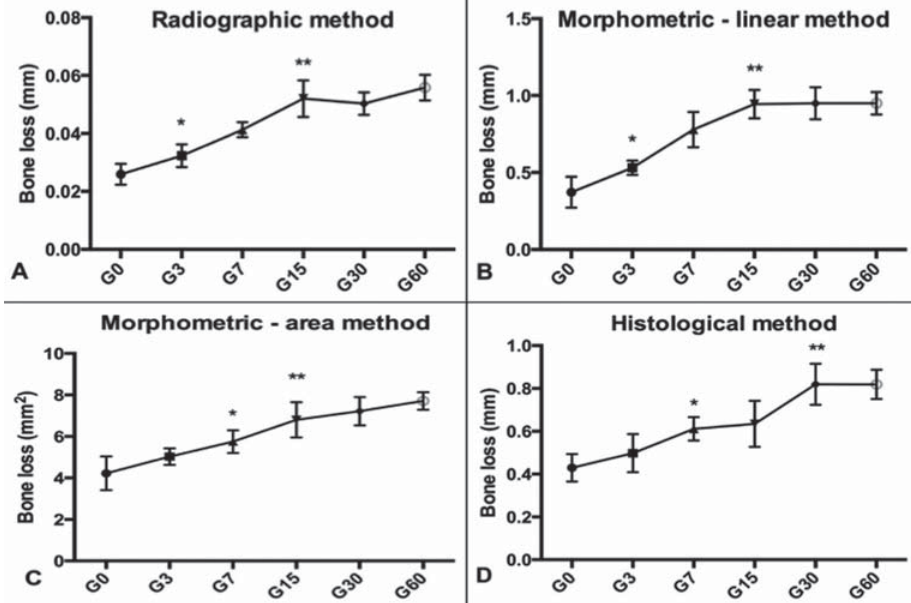
Figure 2- (cid:3)(cid:37)(cid:82)(cid:81)(cid:72)(cid:3)(cid:79)(cid:82)(cid:86)(cid:86)(cid:3)(cid:73)(cid:82)(cid:85)(cid:3)(cid:72)(cid:68)(cid:70)(cid:75)(cid:3)(cid:80)(cid:72)(cid:87)(cid:75)(cid:82)(cid:71)(cid:82)(cid:79)(cid:82)(cid:74)(cid:92)(cid:3)(cid:76)(cid:81)(cid:3)(cid:85)(cid:72)(cid:79)(cid:68)(cid:87)(cid:76)(cid:82)(cid:81)(cid:3)(cid:87)(cid:82)(cid:3)(cid:87)(cid:75)(cid:72)(cid:3)(cid:83)(cid:72)(cid:85)(cid:76)(cid:82)(cid:71)(cid:3)(cid:82)(cid:73)(cid:3)(cid:51)(cid:39)(cid:3)(cid:76)(cid:81)(cid:71)(cid:88)(cid:70)(cid:87)(cid:76)(cid:82)(cid:81)(cid:3)(cid:88)(cid:86)(cid:76)(cid:81)(cid:74)(cid:3)(cid:87)(cid:75)(cid:72)(cid:3)(cid:11)(cid:36)(cid:12)(cid:3)(cid:85)(cid:68)(cid:71)(cid:76)(cid:82)(cid:74)(cid:85)(cid:68)(cid:83)(cid:75)(cid:76)(cid:70)(cid:3)(cid:80)(cid:72)(cid:87)(cid:75)(cid:82)(cid:71)(cid:30)(cid:3)(cid:11)(cid:37)(cid:12)(cid:3)(cid:80)(cid:82)(cid:85)(cid:83)(cid:75)(cid:82)(cid:80)(cid:72)(cid:87)(cid:85)(cid:76)(cid:70)(cid:18)